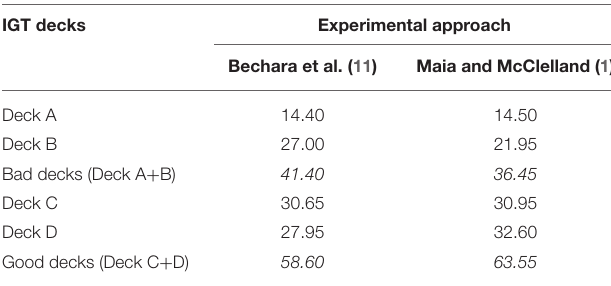
TABLE 2 | Deck selection frequency: Bechara et al. (11) vs. Maia and McClelland